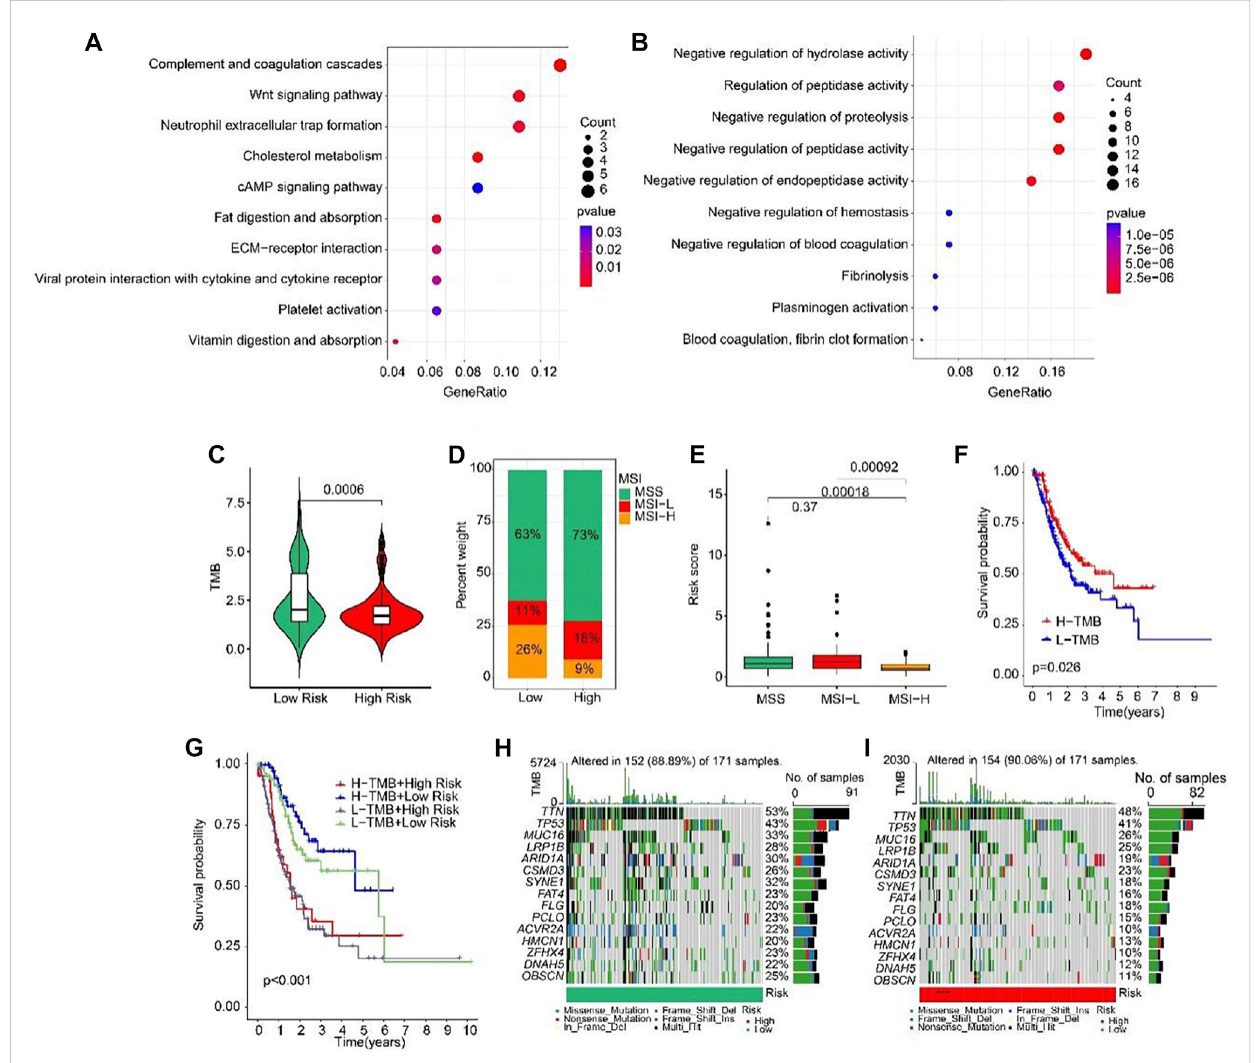
FIGURE 9 Tumor mutation burden and Functional enrichment analysis of DEGs in low- and high-risk group. (A) GO analysis of DEGs in low- and high-risk groups. (B) KEGGanalysisofDEGsinlow-andhigh-riskgroups. (C) Tumormutationburdenbetweenlow-andhigh-riskgroups. (D) MSIpercentbetween low- and high-risk groups. (E) Riskscore between low- and high-riskgroups. (F) The Kaplan-Meier survival curveshows theOS rate ofpatientsin H-TMB and L-TMB groups. (G) The Kaplan-Meier survival curve shows the OS rate of patients in H-TMB + high-risk, H-TMB + low-risk, L-TMB + high risk, and L-TMB + low risk groups. (H, I) The waterfall plot of somatic mutation landscape of low- and high-risk